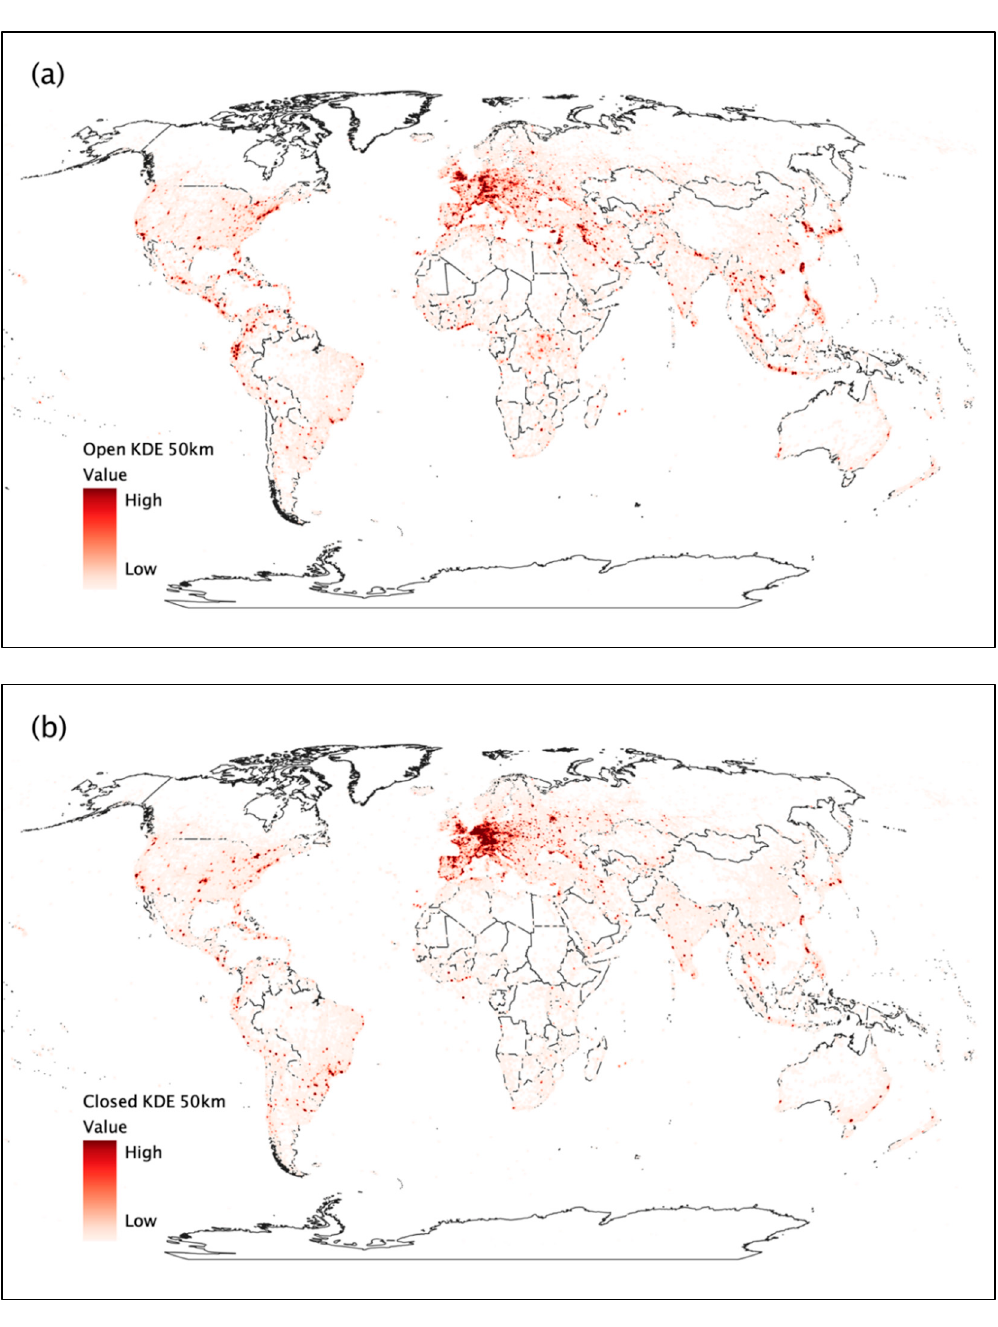
Figure 1. Overview of OSM Notes posted ( a ) open and ( b ) closed using kernel density estimation (KDE).